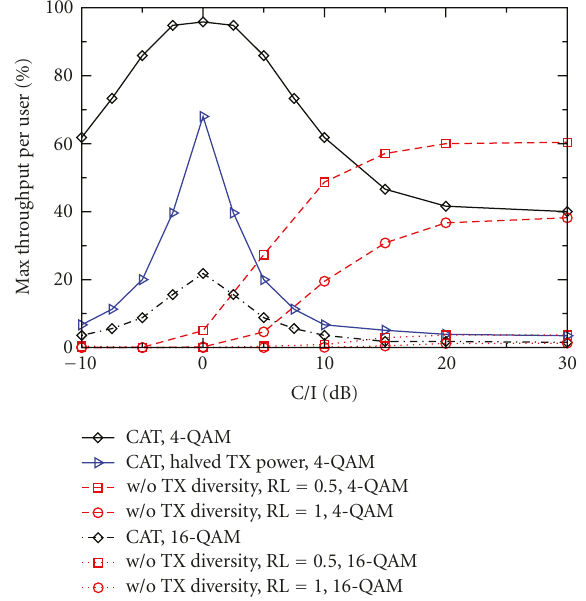
Figure 14: Throughput per user for 4-QAM and 16-QAM versus C/I using no transmit diversity or CAT with full and halved transmit